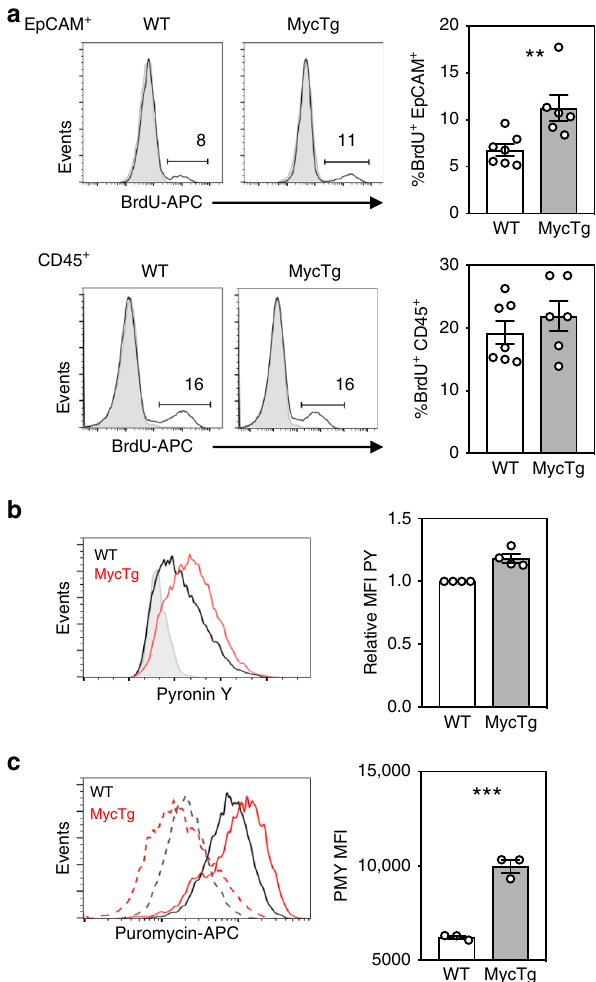
Fig. 6 Myc expression increases the frequency of proliferating TEC and the number of actively translating ribosomes. a Representative histograms and bar graphs of the frequency of BrdU + CD45 − EpCAM + total TEC (above) or BrdU + CD45 + EpCAM − total thymocytes (below) in adult WT or FoxN1MycTg mice. Gray lines on histograms represent the negative control. b A histogram of pyronin Y staining on CD45 − EpCAM + total TEC populations from WT adult (black line) or FoxN1MycTg adults (red line), overlaid against an adult WT sample treated with RNAse (gray line). Bar graph represents pyronin Y MFI relative to the adult WT control, which is set to 1 in all experiments and so has no error bar. c A histogram of puromycin antibody staining on CD45 − EpCAM + total TEC from adult WT (black) or FoxN1MycTg (red) mice treated with either puromycin (PMY) plus cxcycloheximide (CHX) staining (solid lines) or puromycin plus harringtonine (HNT) (dotted lines). Bar graph represents the MFI of puromycin (PMY) gated on total TEC from WT adult or FoxN1MycTg adults, calculated from the MFI of PMY + CHX treated mice, from which we subtracted the MFI from PMY + HNT treated mice to eliminate the signal associated with stalled ribosomes. All bar graphs show mean ± SEM for a minimum of n = 3 mice per genotype. A two-tailed unpaired Student ’ s t test was performed to determine signi fi cance. ** p < 0.01, *** p < 0.001. The source data underlying fi gures are provided as a Source Data fi